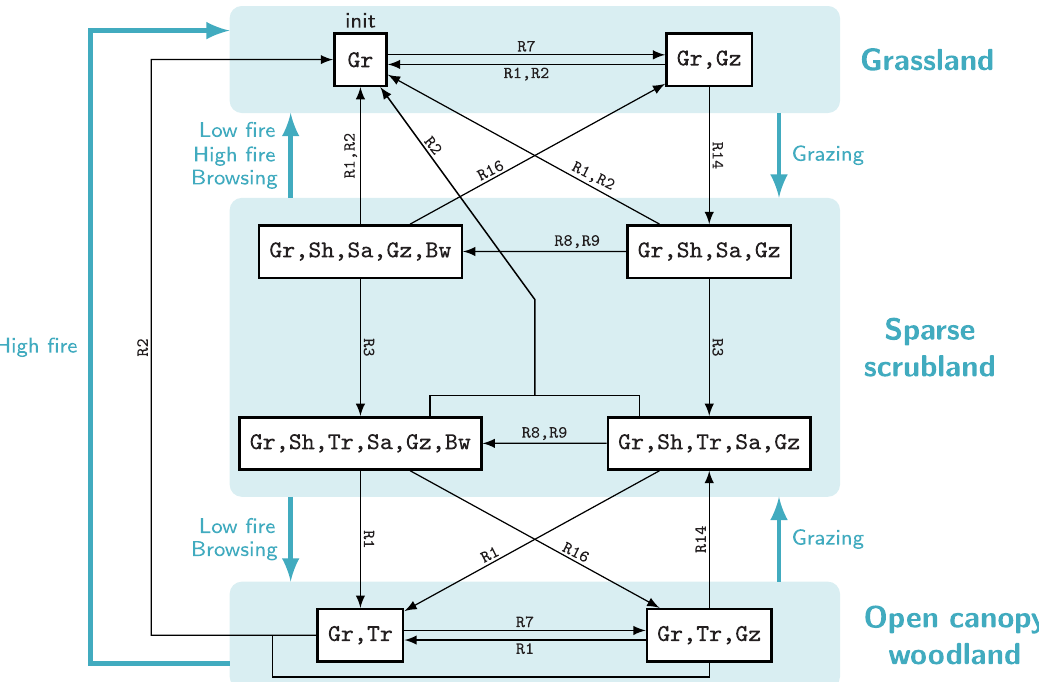
Fig 6. Scenario subgraph computed by the Borana model . This subgraph corresponds to the scenario with wildlife and fire at high altitude ( Alt+,Fb-,Cb+,Wl+,Ps-,Ig-,BLv- ), the scenario at low altitude is similar (see S1 Notebook). The states are displayed as white squares, the variables within a square represent the variables valuated “+” in this state. From the initial state (top left), the subgraph is computed by the cascading applications of the if-then rules (S1 Table). The transitions are labelled by the rules that produced them, if several rules produced the same transition then it is labelled by all of them, separated by commas. The states belonging to the same vegetation class (S2 Table) are gathered inside a blue rounded box labelled by the name of the vegetation class. Each transition from a state in a vegetation class to a state in another vegetation class, gives rise to a transition between the two classes in the same direction and labelled by the tags of the corresponding rules. For instance,